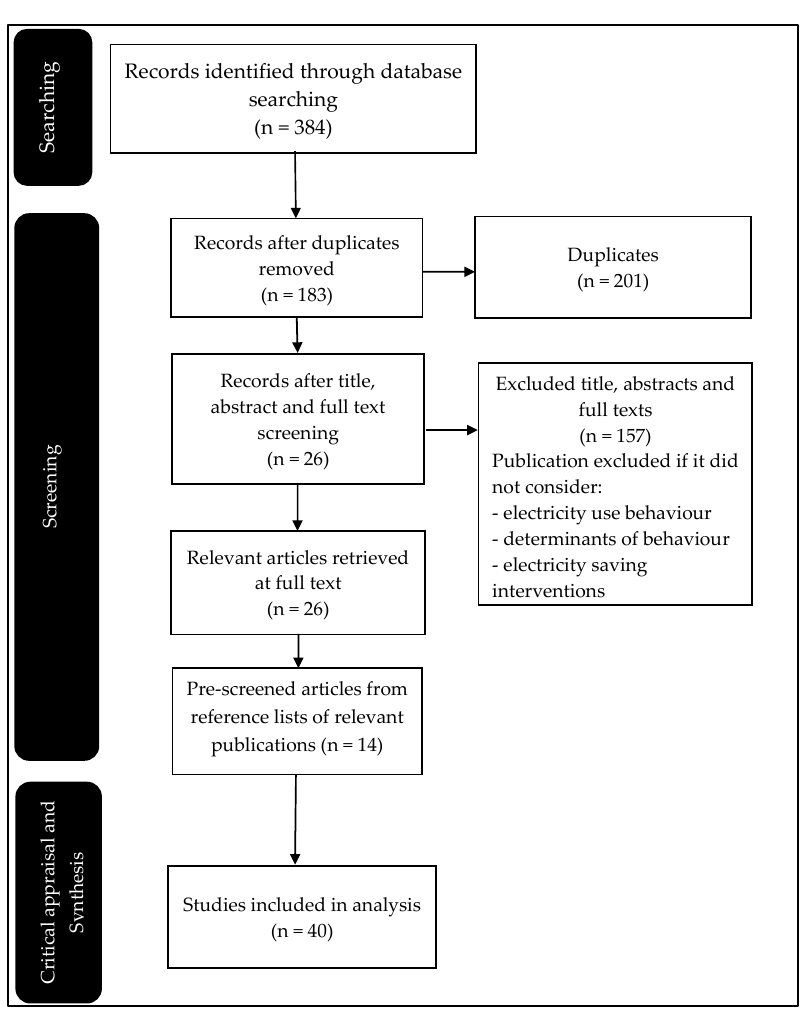
Figure 1. Flow diagram for publication search and screening following Systematic Evidence Synthesis (ROSE).